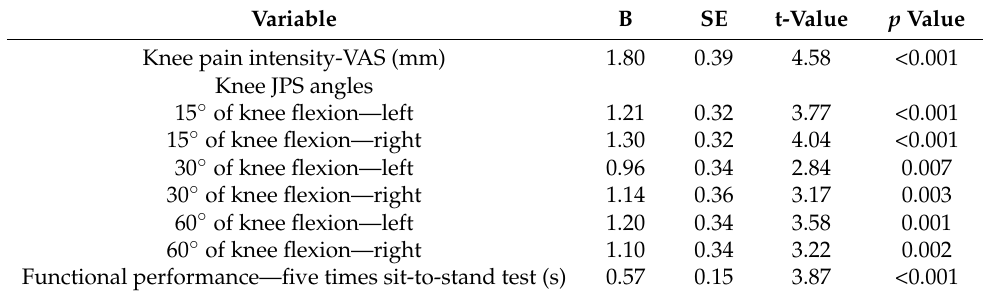
Table 3. Simple linear regression of TSK scores and explanatory variables ( n =